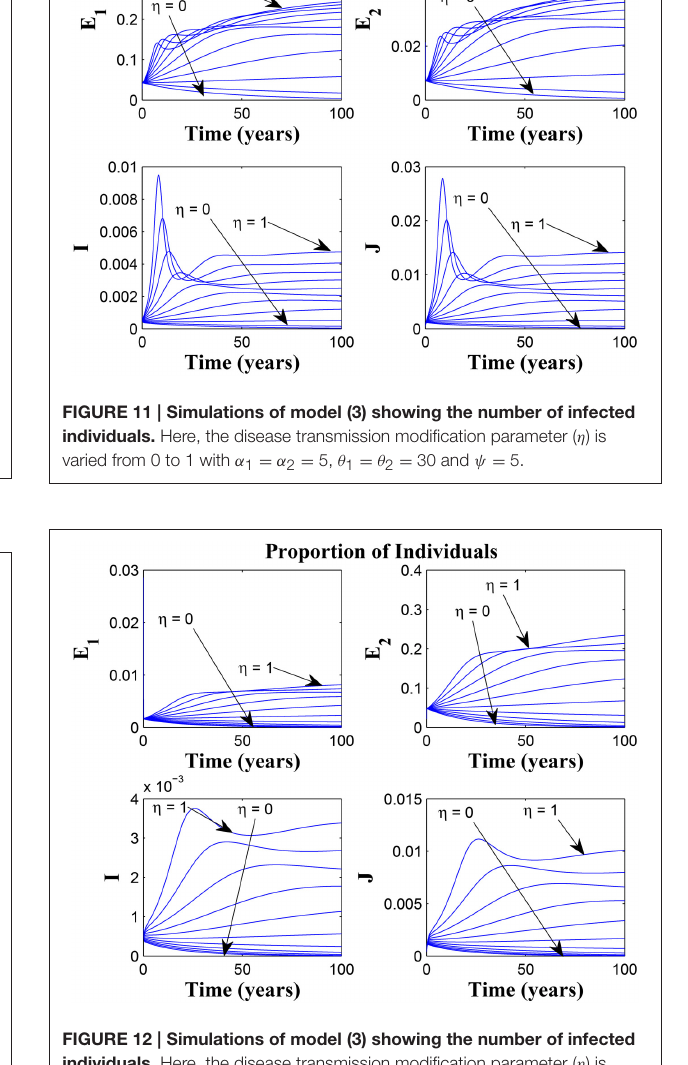
FIGURE 10 | Simulations of model (3) showing the number of infected individuals. Here, the rate at which susceptibles lose awareness ( θ 1 ) is varied from 0 to 30 with α 1 = 30 and α 2 = 5 .